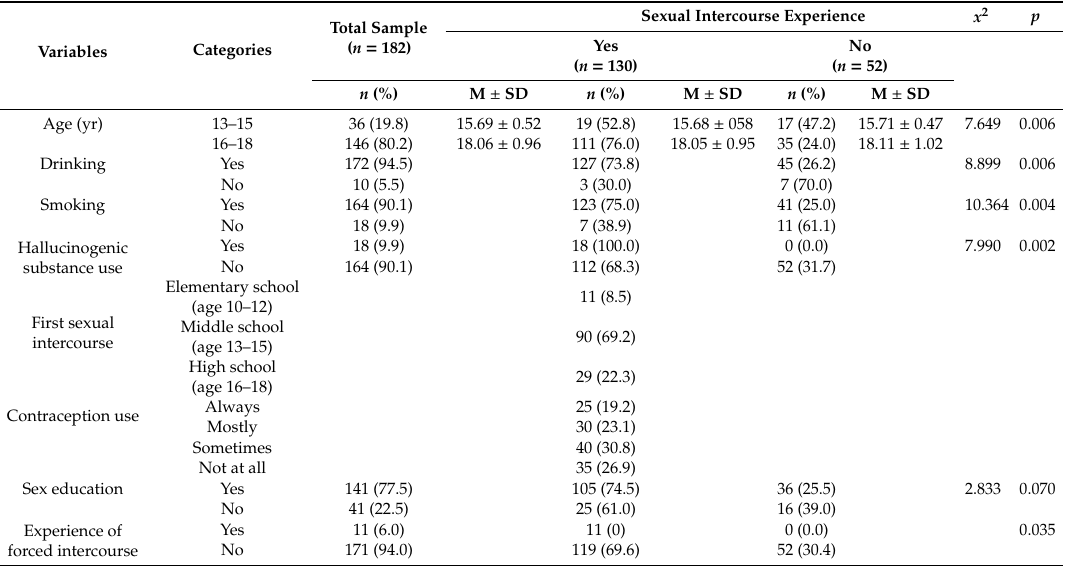
Table 1. General characteristics based on sexual intercourse experience ( N =